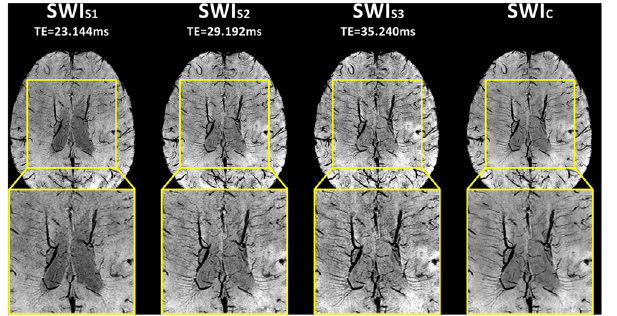
Fig 3. Evaluation of asymmetric medullary veins (AMV) in single-echo and combined multi-echo susceptibility weighted imaging (SWI) images. Contrast between veins and adjacent white matter tissues was better visible in the combined multi-echo SWI (SWI c ) image than different echoes of single-echo SWI (SWI s ) images. Detection of AMV in SWI s2 (TE = 29.192 ms) and SWI s3 (TE = 35.240 ms) was the same as that in SWI c . However, AMV was ambiguous in SWI s1 (TE = 23.144